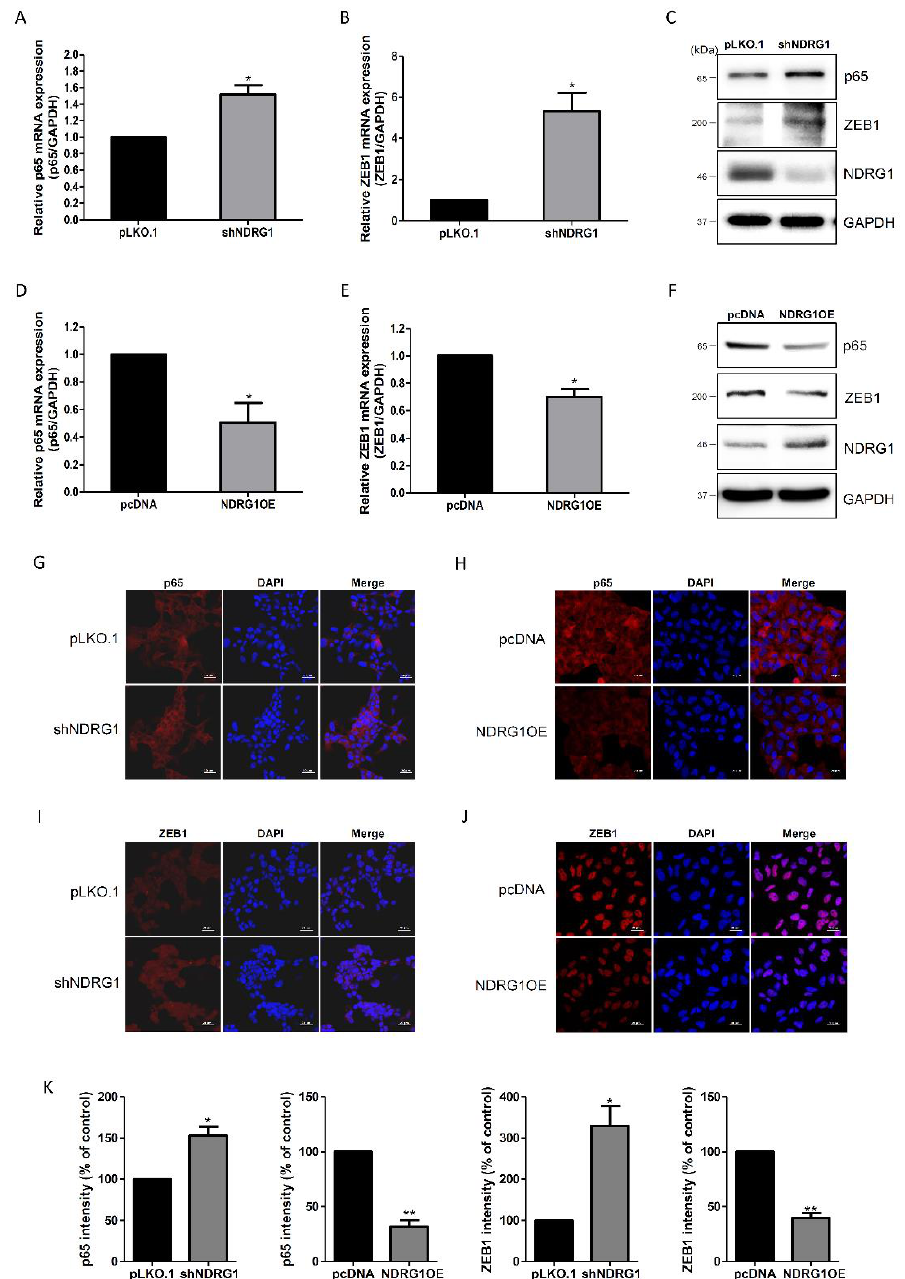
Figure 5. NDRG1 downregulated the NF- κ B/ZEB1 pathway in endometrial epithelial cells. ( A ) Effect of NDRG1 depletion on p65 mRNA expression in RL95-2 cells. ( B ) Effect of NDRG1 depletion on ZEB1 mRNA expression in RL95-2 cells. ( C ) Analysis of p65 and ZEB1 protein after NDRG1 depletion in RL95-2 cells. ( D ) Effect of NDRG1 overexpression on p65 mRNA expression in AN3-CA cells. ( E ) Effect of NDRG1 overexpression on ZEB1 mRNA expression in AN3-CA cells. ( F ) Analysis of p65 and ZEB1 protein after NDRG1 overexpression in AN3-CA cells. ( G , H ) Immunofluorescence images of p65 protein expression in NDRG1-depleted or -overexpressing cells. ( I , J ) Immunofluorescence images of ZEB1 protein expression in NDRG1-depleted or -overexpressing cells. ( K ) Quantification of immunofluorescence images using image J. All images are shown at 400 × magnification. Scale bars indicate 20 μ m. Nuclei were stained with DAPI. The data shown represent the mean ± SEM from three independent experiments (n = 3). * p < 0.05; ** p < 0.01.